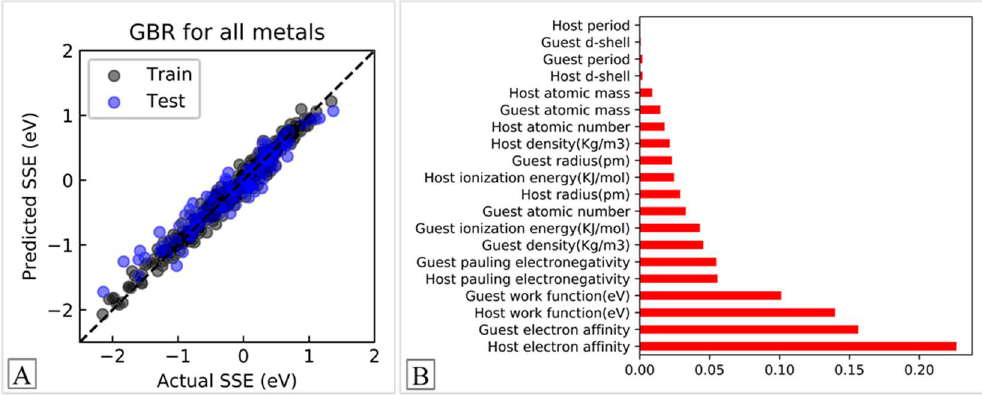
Figure 7. GBR model predictions for HCP(001) surfaces using ( A ) 11 features and ( B ) 5 features. SSE = surface segregation energy. Figure 8. ( A ) Model predictions and ( B ) Feature importance scores for combined [FCC (111) + BCC (110) + HCP (001) surfaces] dataset obtained from the GBR model. SSE = surface segregation energy.